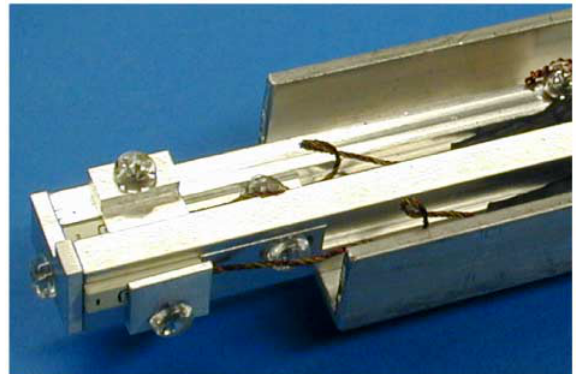
FIG. 11. (Color) Two Hall sensors MPT-141 installed on a two- axis holder. The axes of the Hall sensors intersect at right angles to each